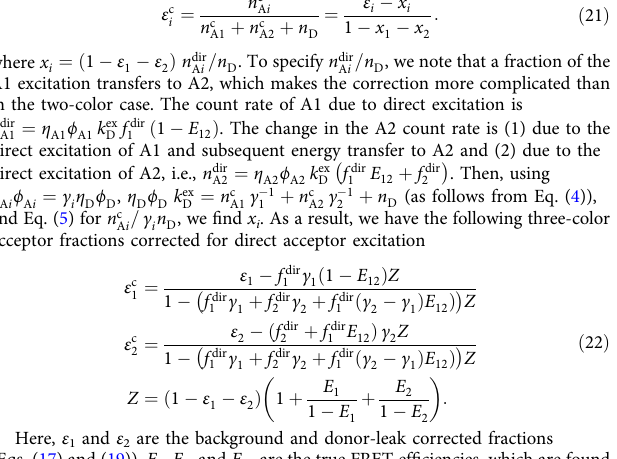
four rate coef fi cients for blinking of A1 and A2, labeling ef fi ciency of A2 ( φ ), and two rate coef fi cients for photobleaching (and slow blinking) of A2.